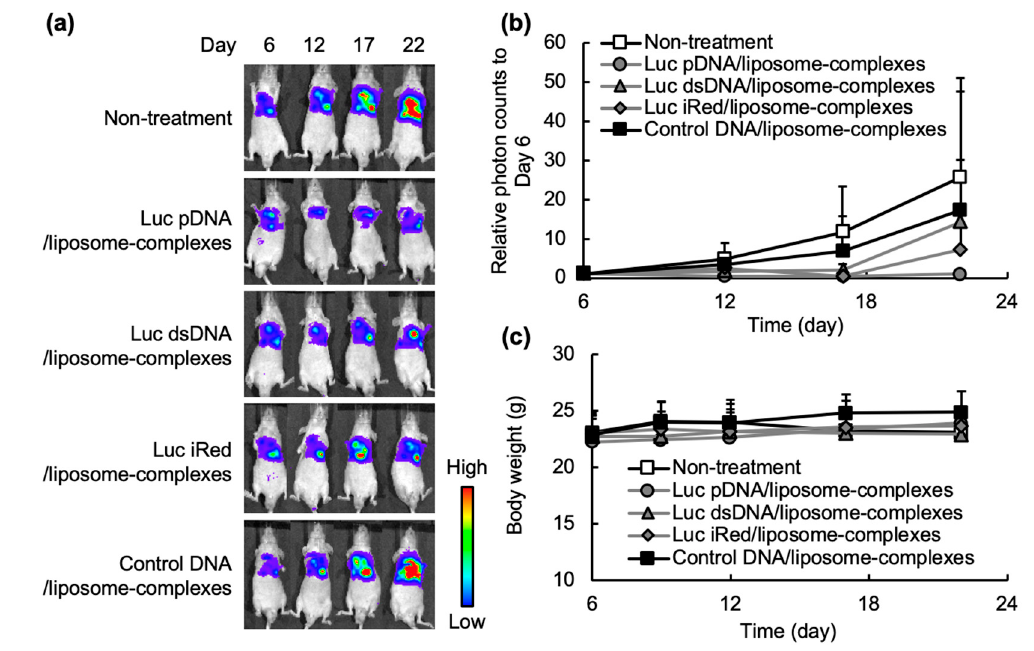
Figure 3. In vivo evaluation of RNAi activities of various di ff erent DNAs formulated in DNA / liposome-complexes. Orthotopic mesothelioma-bearing mice were intrapleurally injected with two doses of Luc pDNA / liposome-complexes, Luc dsDNA / liposome-complexes, Luc iRed / liposome-complexes or control DNA / liposome-complexes (10 µ g DNA / mouse / day) at day 7 and at day 10 after inoculation of tumor cells. At days 6, 12, 17 and 22 after cell inoculation, the luciferase activity of the pleural tumor was visualized using an in vivo imaging system (IVIS). ( a ) Time course of bioluminescence intensities. ( b ) Time course of luciferase activity expressed as relative photon counts compared to that at day 6 post tumor cell inoculation. ( c ) The body weight of the mice determined from day 6 to day 22 following tumor cell inoculations. In the ( b , c ), data are reported as the mean ± SD ( n = 5). Table 2. Inhibition rate of DNAs / liposome-complexes calculated from the data in Figure 3b. Complexes Inhibition Rate (% / mol)